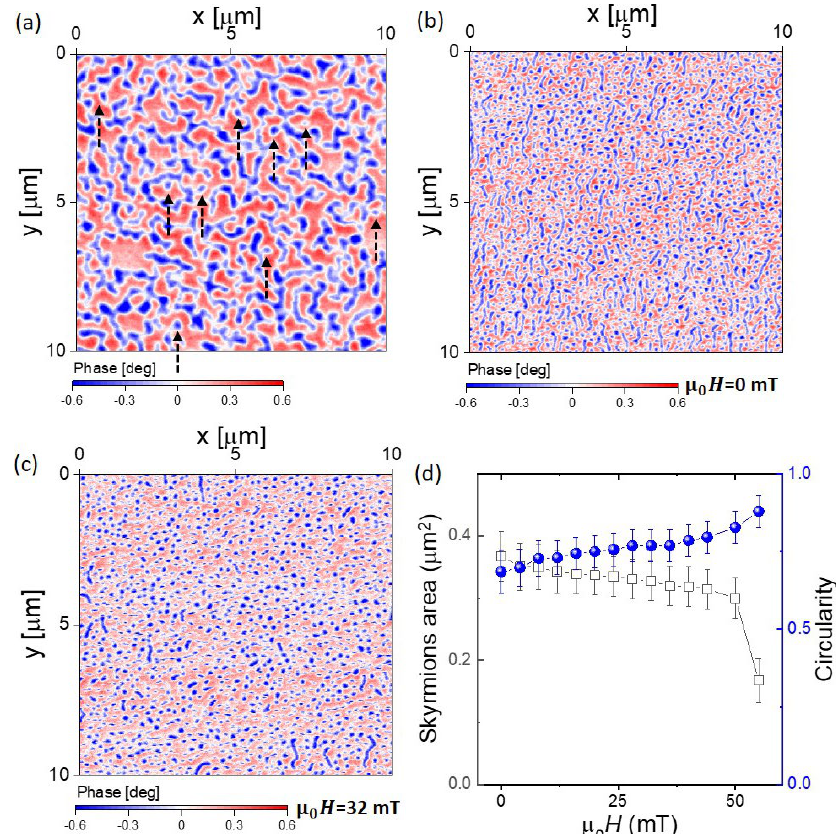
Figure 2. MFM measurements on [Ir/Co/Pt] 5 multilayers for t Co = 0.8 nm at room temperature. ( a ) The MFM image was acquired in the as-grown state. Red and blue contrast represents out-of-plane magnetisation of opposite directions. Some skyrmions are indicated by dashed black arrows. ( b ) Magnetic state following the “in-plane field procedure”. ( c ) Example of the evolution of skyrmions vs. the perpendicular applied magnetic field at µ 0 H = 32 mT . ( d ) Plot showing the area of the skyrmions (open square) and circularity (blue spheres) vs. µ 0 H